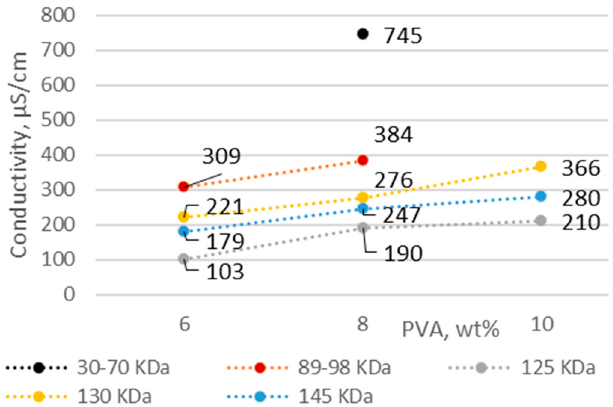
Figure 2. The electrical conductivity values of electrospinning solutions depending on the concentration and molecular weight of polyvinyl alcohol.